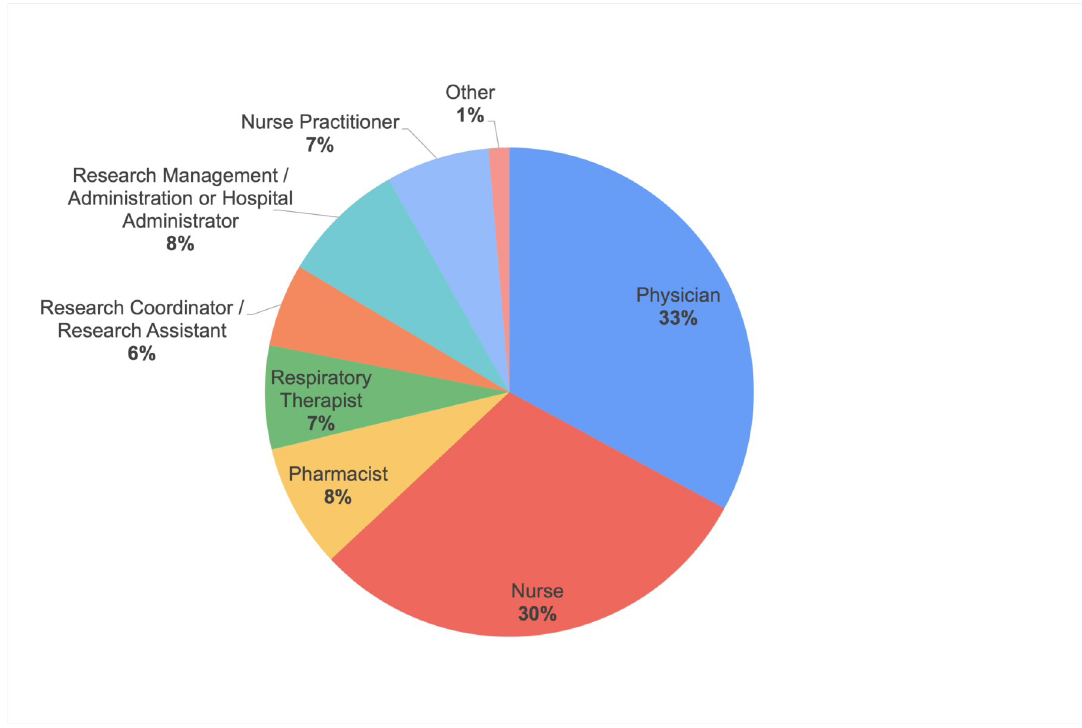
Fig 1. Participant demographics–by